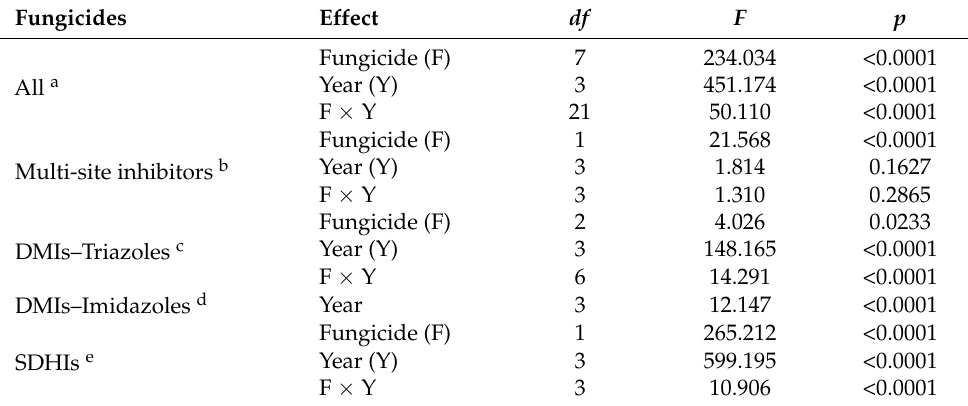
Table 1. Analyses of variance (ANOVAs) for the effect of fungicide (all, multi-site inhibitors, DMIs, SDHIs) and year of Zymoseptoria tritici isolation (1999, 2009, 2014, 2020) and their interaction on EC 50 values (mg/L) of Z. tritici